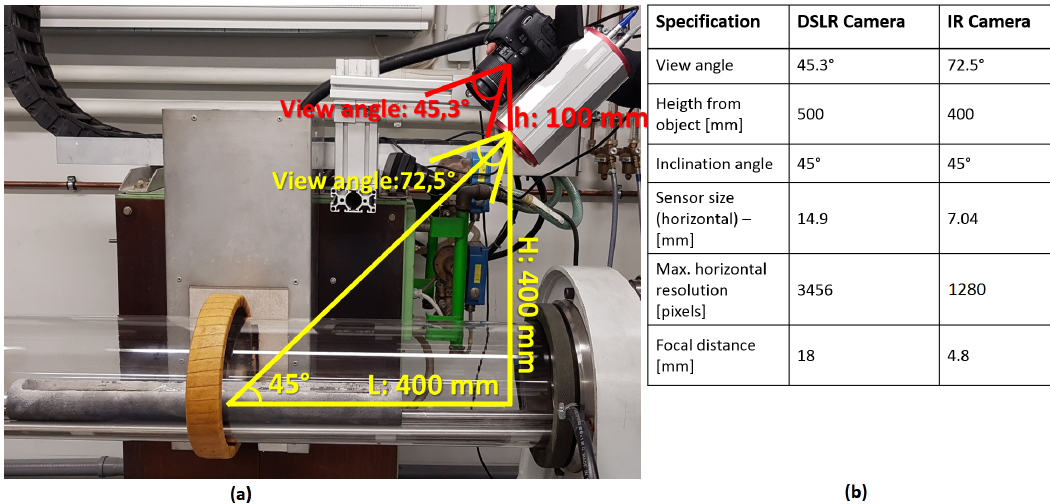
Figure 4. ( a ) Horizontal zone refining equipment with a single induction heater at IME Institute of RWTH University showing the position and ( b ) technical details of an infrared, as well as a DSLR camera.